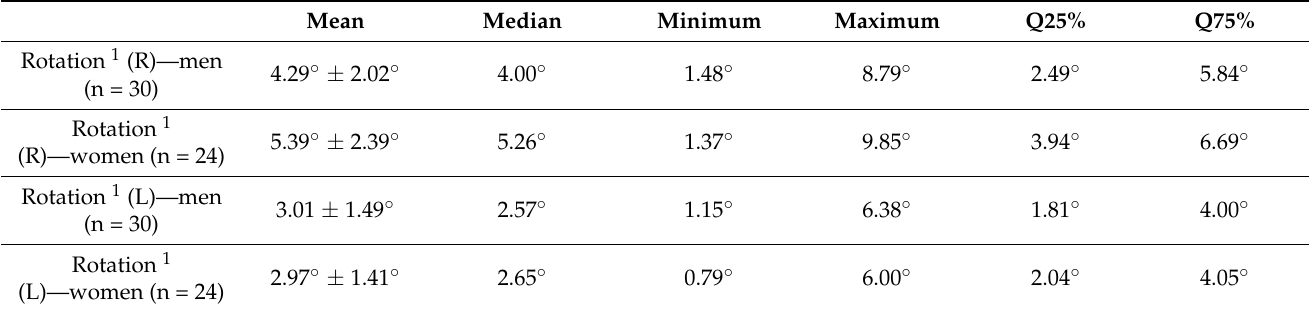
Table 4. Rotation [degrees] of the lumbar spine (L1–L5) in men and women. Mean Median Minimum Maximum Q25% Q75%